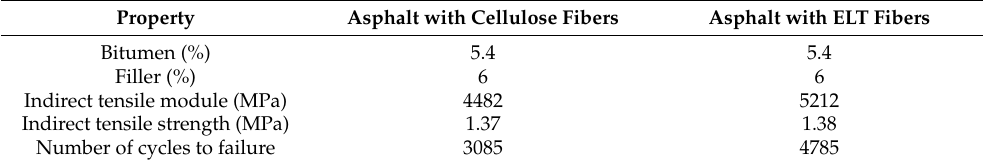
Figure 12. Fiber pellets obtained with ( left ) and without ( right ) paraffin wax [10]. Table 4. Comparison between two different types of asphalt with cellulose fibers and ELT fibers [10].